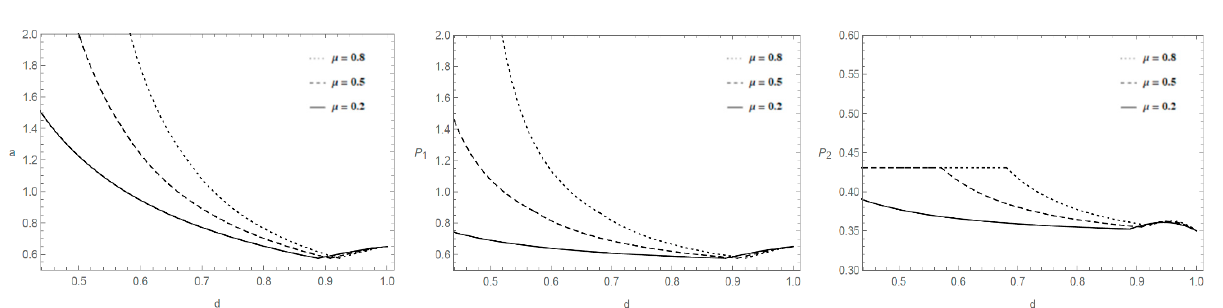
Figure 3. Comparison of Cover and Retail Prices of Printed and E-books. ( a is the cover price of printed book; P 1 is the retail price of printed book; P 2 is the retail price of e-book; d is the publisher’s wholesale discount rate of the printed book; µ is the degree of consumers’ concern about a discount).